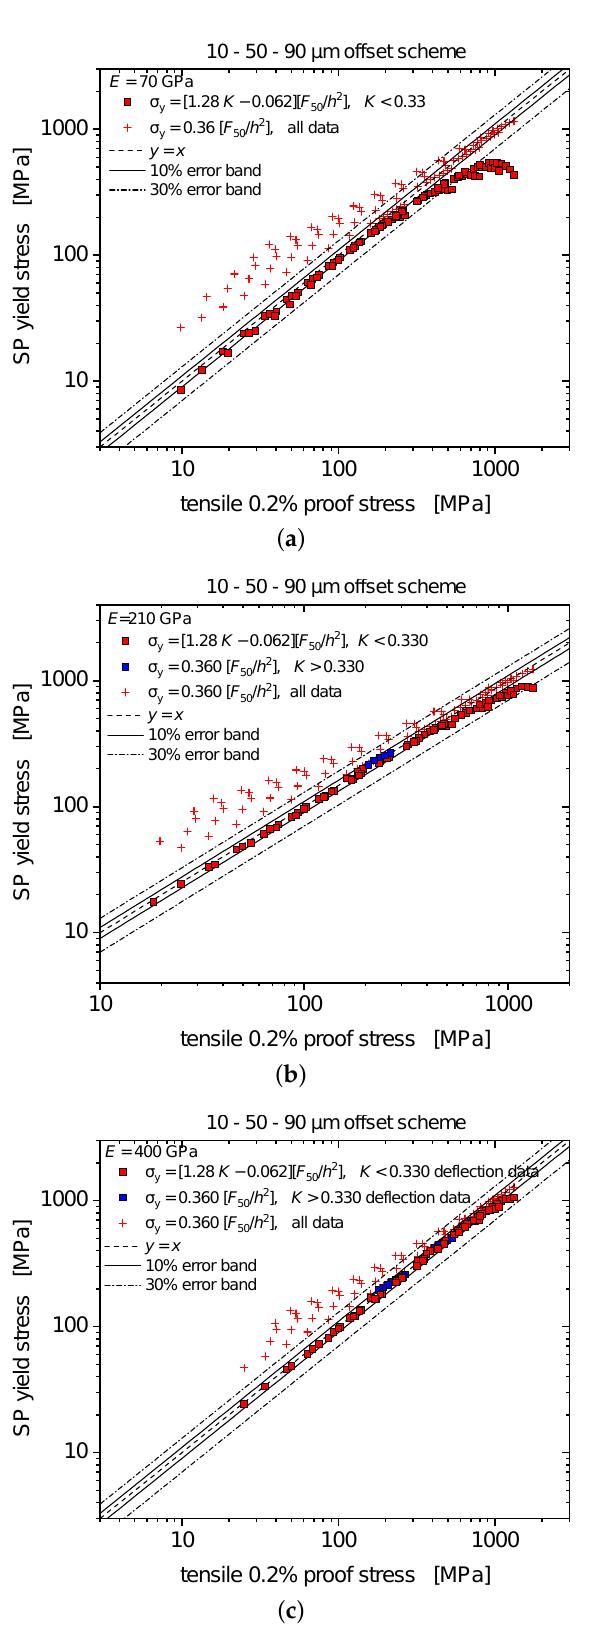
Figure 3. Predictive capability of the displacement-based scheme Equation (3) as applied to deflection data: predicted yield stress vs. numerically implemented proof stress (as determined by Equation (2) for 0.2% of strain) for E = 70 GPa ( a ), 210 GPa ( b ) and 400 GPa ( c ), respectively. If compared with the traditional formula (Equation (1)), cf. red cross symbols, the degree of agreement is much superior with the K dependent